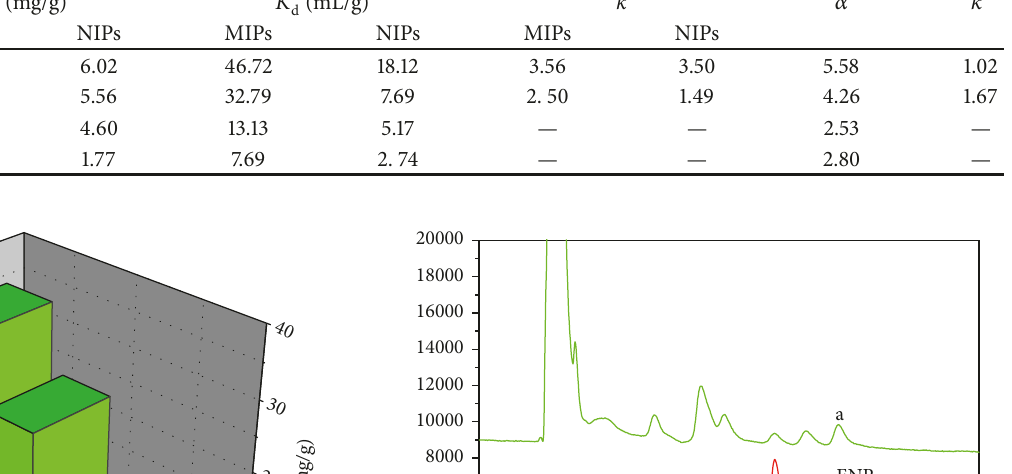
@MIPs and P GMA - EDMA